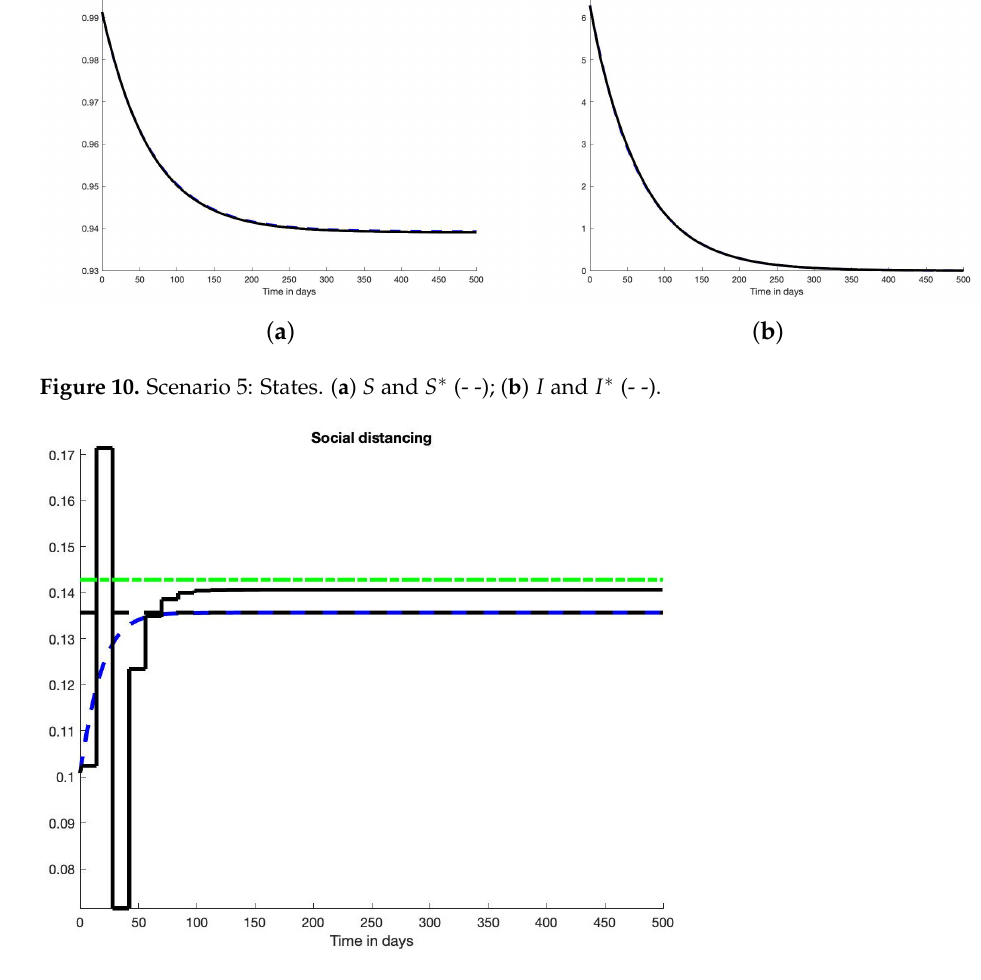
Figure 11. Scenario 5: Control. β , β ∗ (- -, blue), γ (- ., green) and β acceptable (- -,